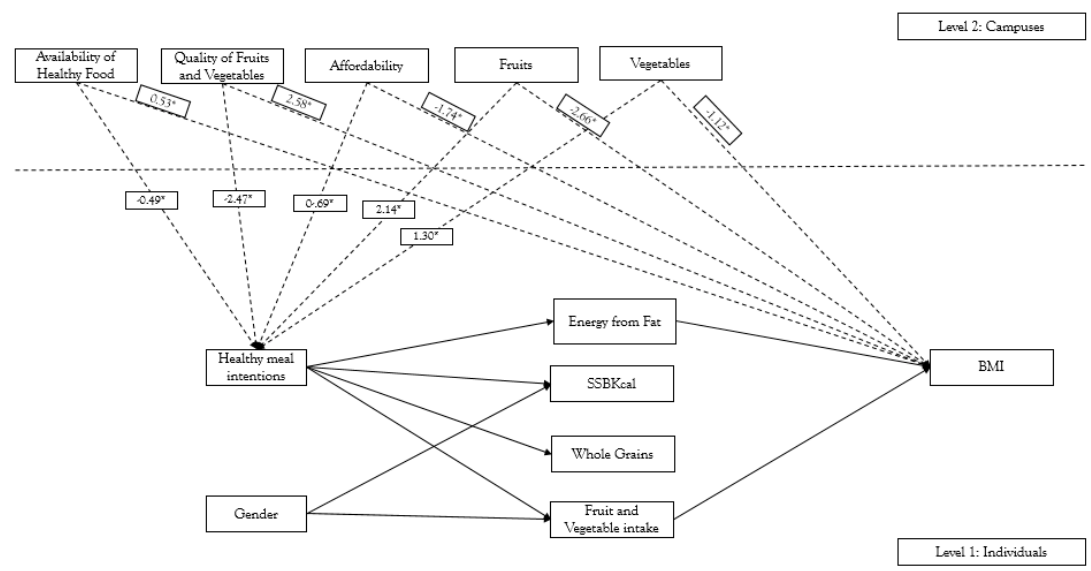
Figure 2. Multilevel structural equation modeling: Level 2—Campuses healthfulness of store